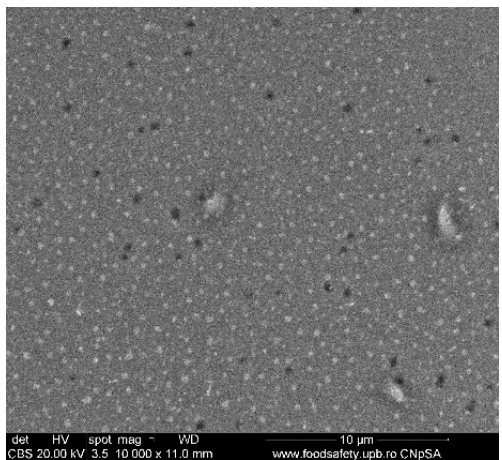
Figure 10. SEM image of 1.1%rGO-SiO 2 /glass.